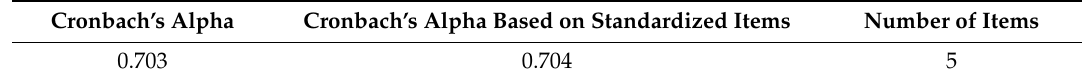
Table 7. Reliability analysis and reliability statistics.